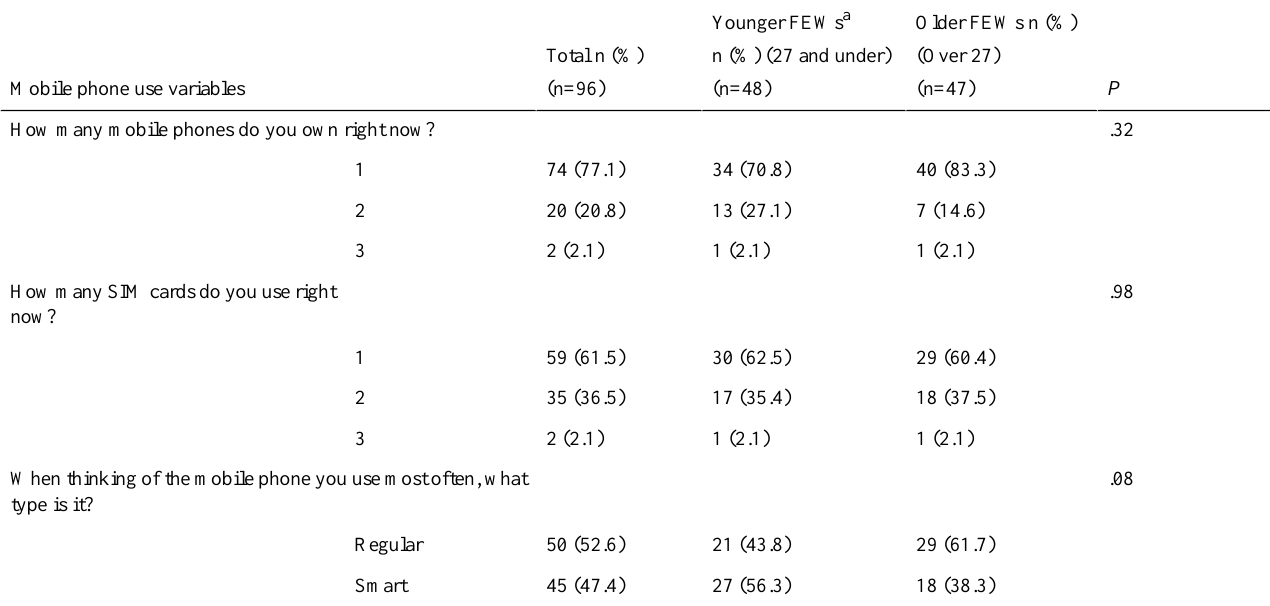
Table 3. Mobile phone use of study participants by age group